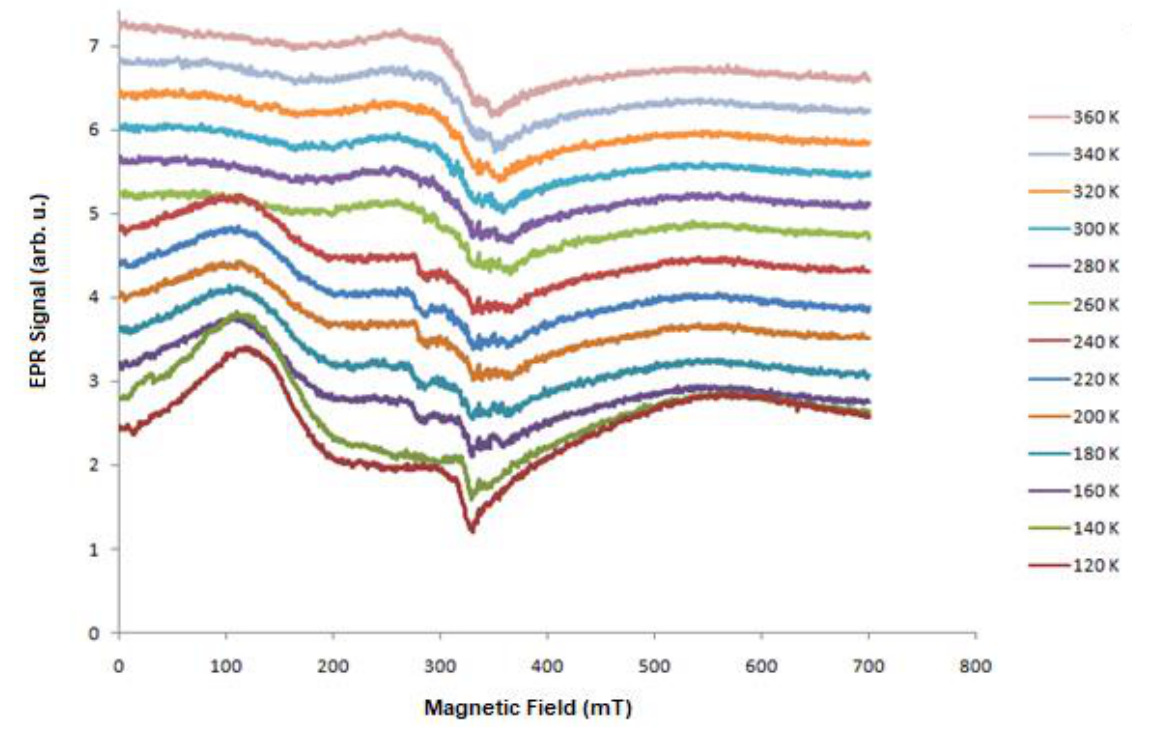
Figure 4. Temperature dependence of the PbTe EPR signal (N111).